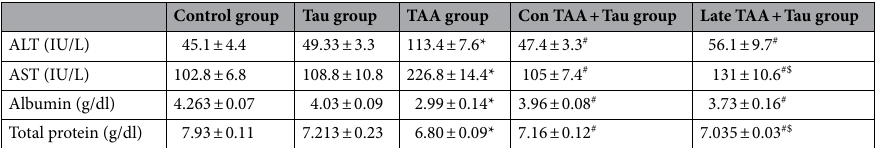
Table 1. Liver function analysis. ALT, alanine aminotransferase; AST, aspartate aminotransferase; Tau, taurine; TAA, thioacetamide. *Significance against control group ( P < 0.05), # Significance against TAA group ( P < 0.05), $ Significance against Con TAA + Tau group ( P <